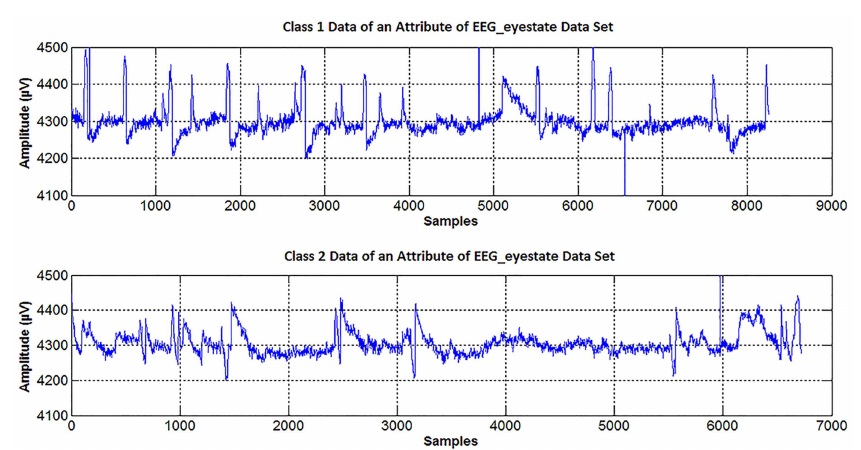
Fig 7. The time-amplitude representations of classesbelonging to the same attribute. This attribute is also used in this study.